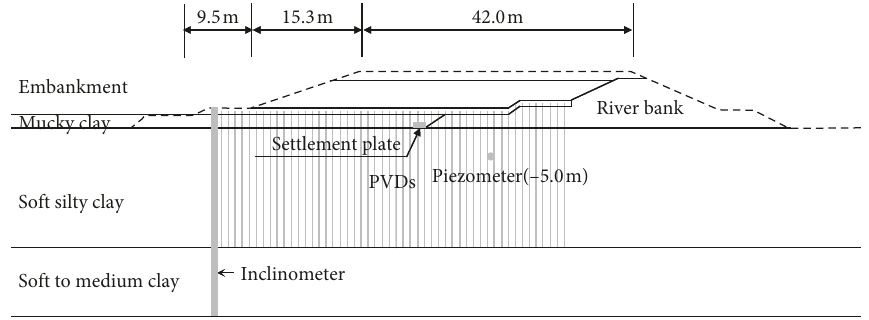
Figure 1: Foundation profile and field instruments